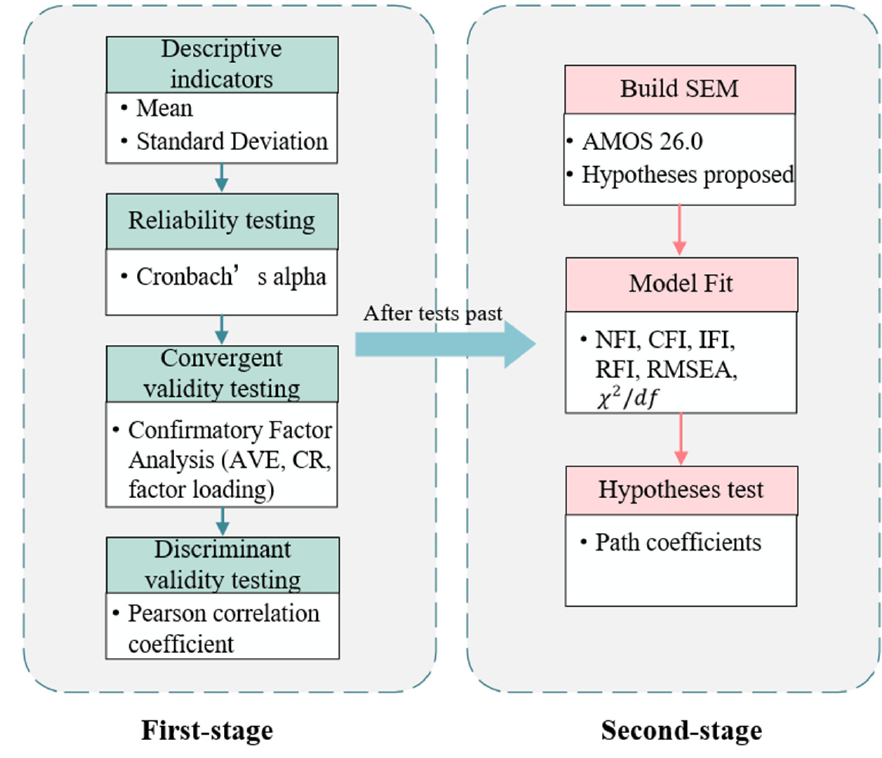
Figure 5. Data analysis process and verification indicators.